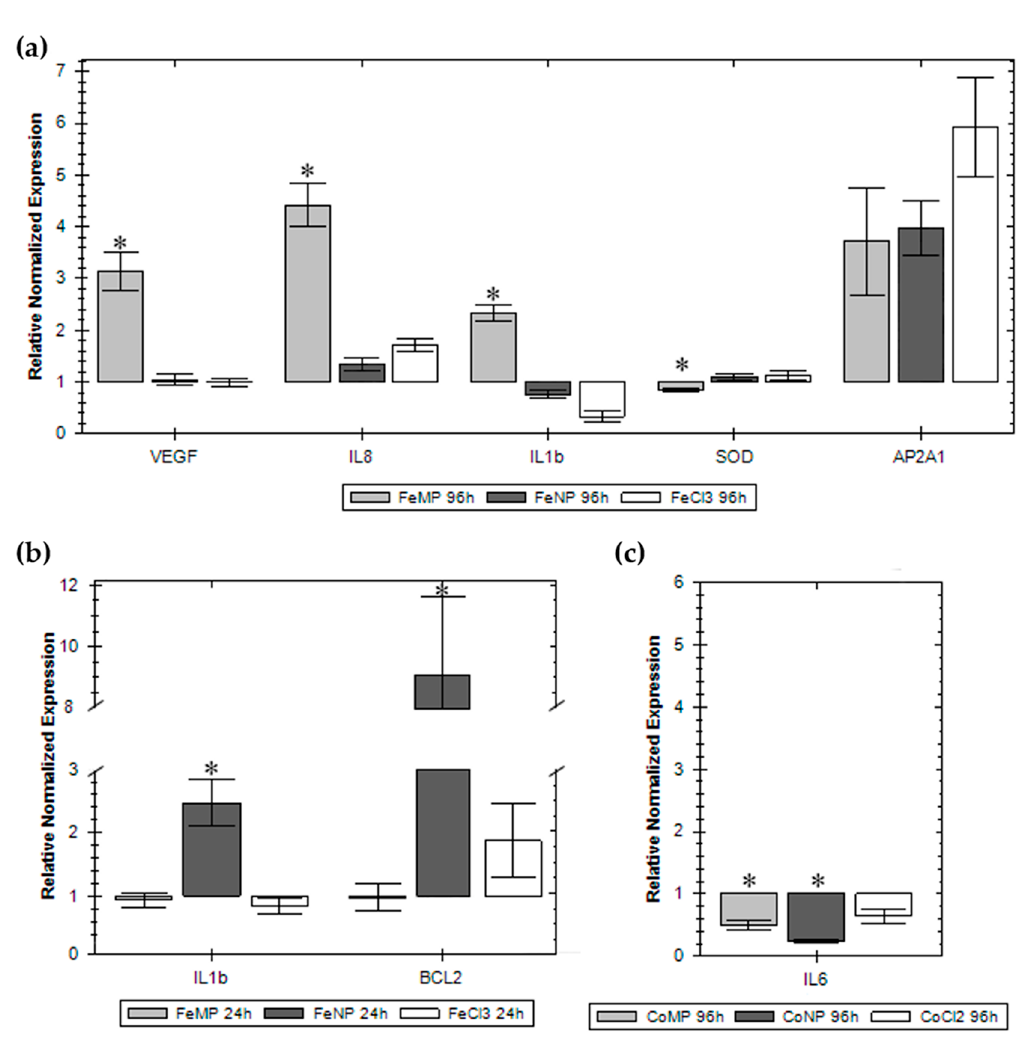
Figure 6. Real-time PCR of the most significant gene expression modifications . VEGF , IL8 , IL1b , SOD and AP2A1 in cells exposed for 96h to Fe MPs, NPs and ion ( a ). IL1b and BCL2 in cells exposed for 24 h to Fe MPs, NPs and ion ( b ). IL6 in cells exposed for 96h to Co MPs, NPs and ion ( c ). Normalization has been done with at least three housekeeping genes. The mRNA expression is reported as the fold change compared to the unexposed cells whose expression has been fixed at one. * Dunnett’s test, p < 0.05. Each plotted value is the mean of three independent samples.